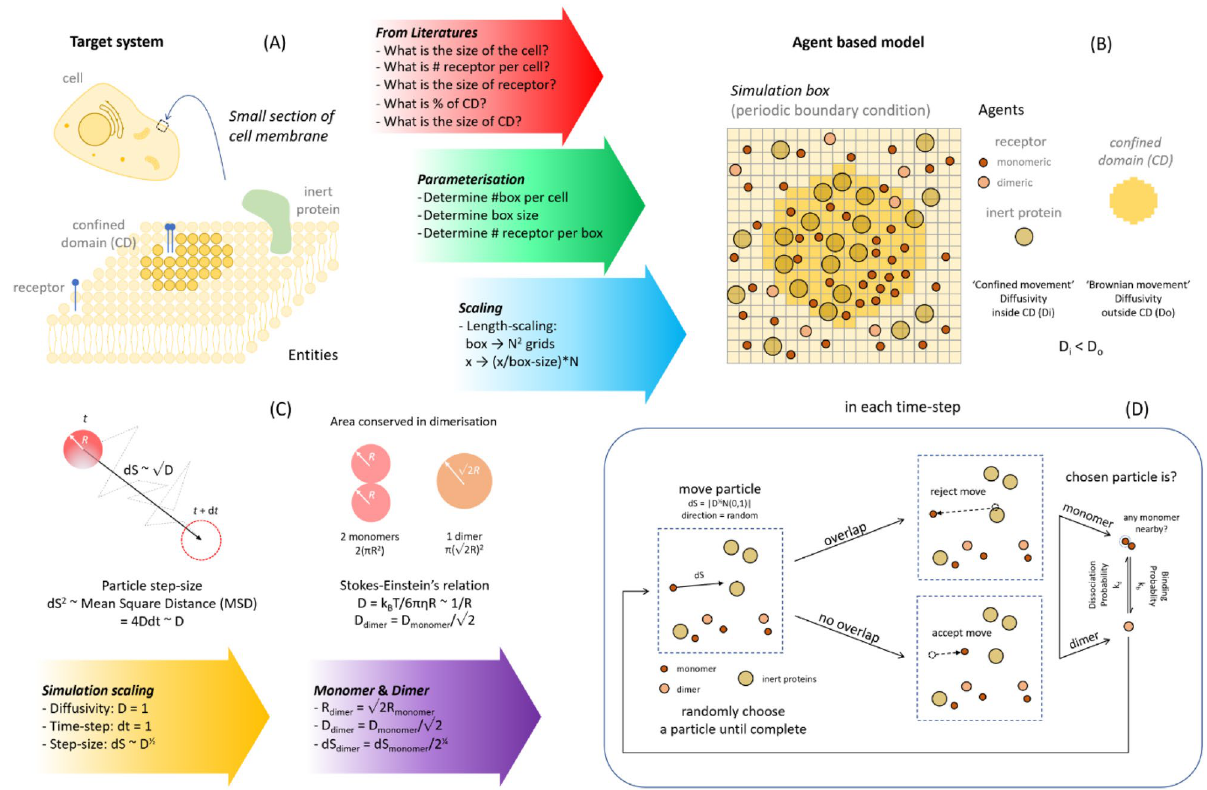
Figure 2. Overview of ABM simulation procedure. ( A ) The target system, i.e. the platelet membrane. The simplified version of a membrane consists of two areas, i.e. parts where molecules are confined in movements (confined domains), and the remaining part where they move freely (Brownian motion). In addition to inert proteins, the receptors of interest are indicated as transmembrane proteins. ( B ) Application of ABM to target receptor dimerisation. The membrane in the simulation box consists of agents (receptor molecules) in monomeric or dimeric forms and inert proteins. The confined domains are considered to represent lipid rafts. All agents are treated as independent, of which mathematical rules determine their properties and interactions. ( C ) Assignment of agent parameters. The simulation parameters included diffusivity, particle size and step size. ( D ) Rules for agent movements. Each simulation step consists of a randomly placed agent with random walk (rejected in case of overlapping), dimerisation and dissociation. Steps are repeated until all agents are selected, after which movements